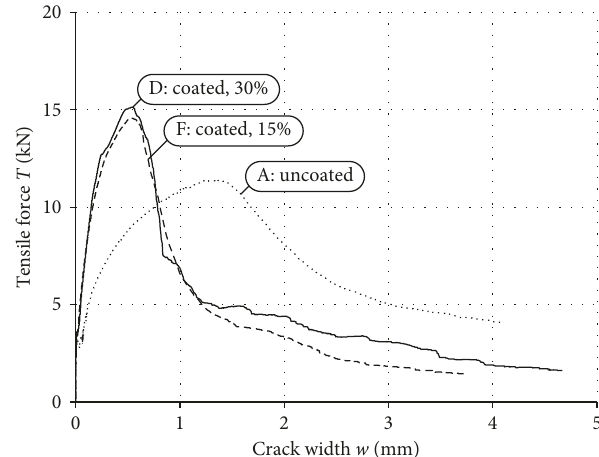
Figure 14: Effect of additional coating.